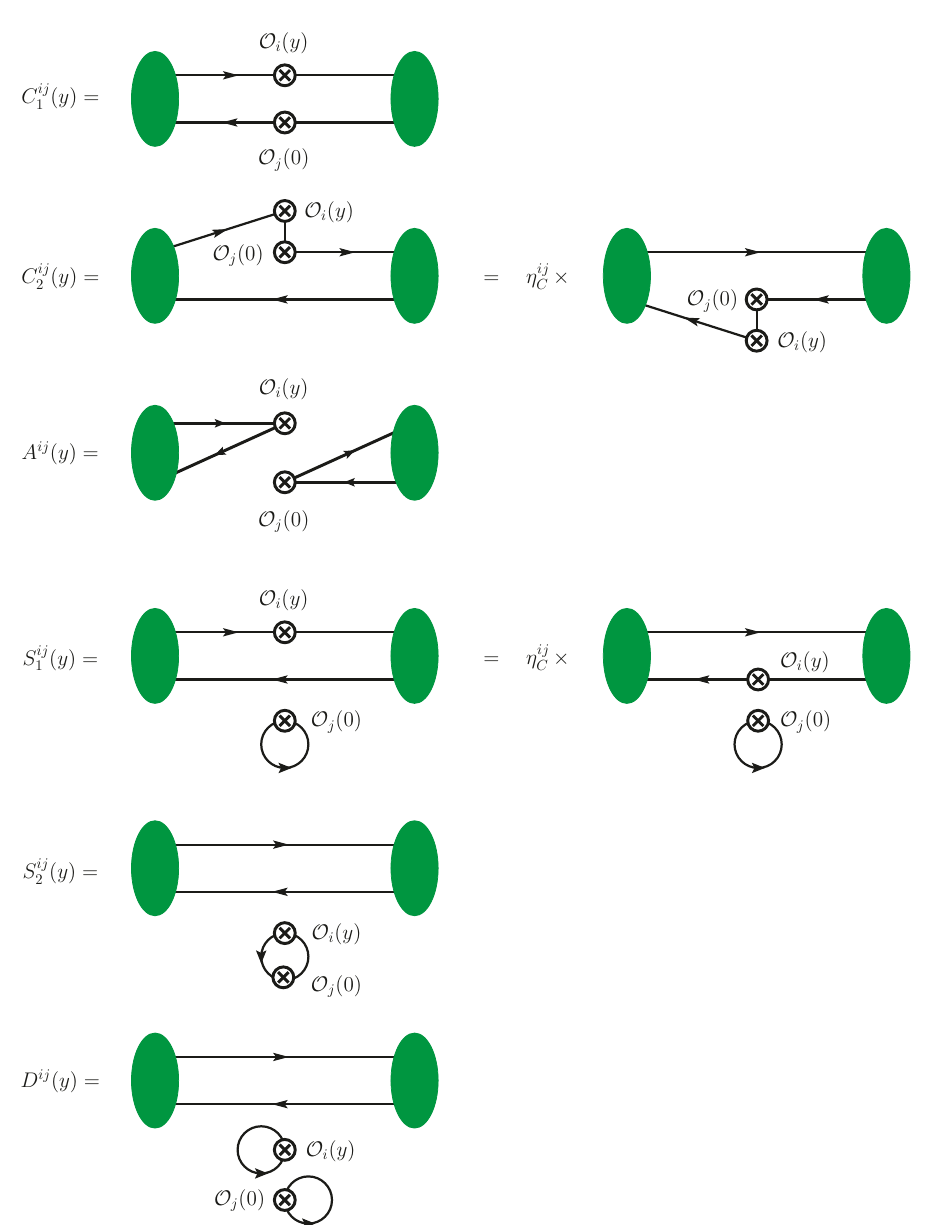
Figure 2. Lattice contractions for the two-current correlation function (2.1) in a pion. The dependence on the pion momentum p is not indicated for brevity. The product (cid:17) ij conjugation parities of the two operators is de(cid:12)ned below (2.7).